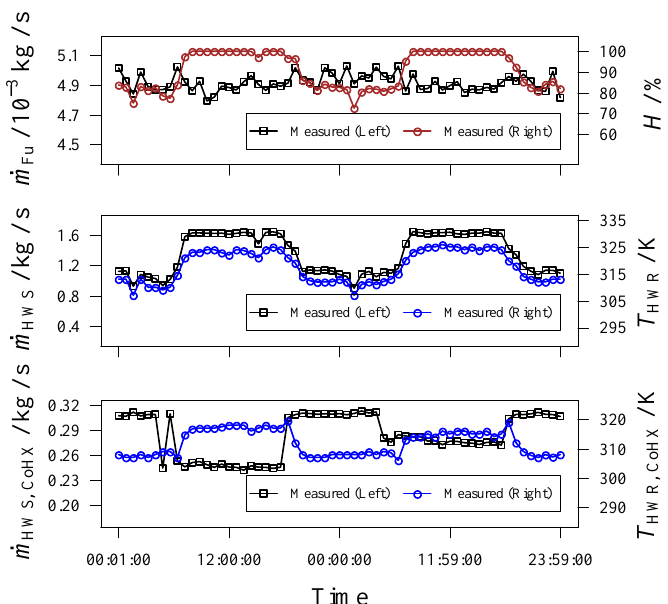
Figure 8. Input signals for the validation of the MGT system model, namely mass flow rates, temperatures and valve opening over time. The one minute time interval signals of the Capstone C65 MGT were for the experimental time period from 20 to 21 November 2013. Note: The pumps in the MGTHX and CoHX hot water circuit operated at a constant speed of 60% and 50%, respectively, during the experiment. The input pressure signal was set to 1.1bar for the MGTHX and CoHX hot water circuit.